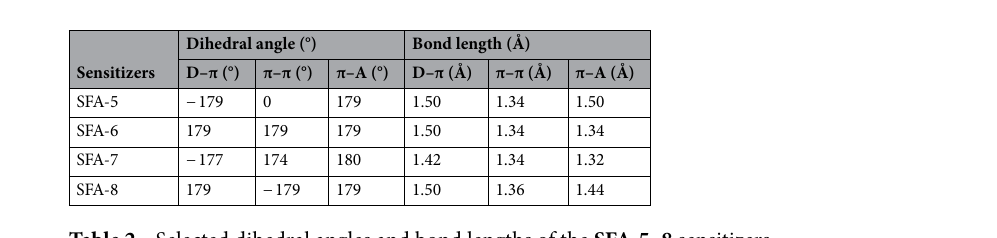
Table 2. Selected dihedral angles and bond lengths of the SFA-5–8 sensitizers